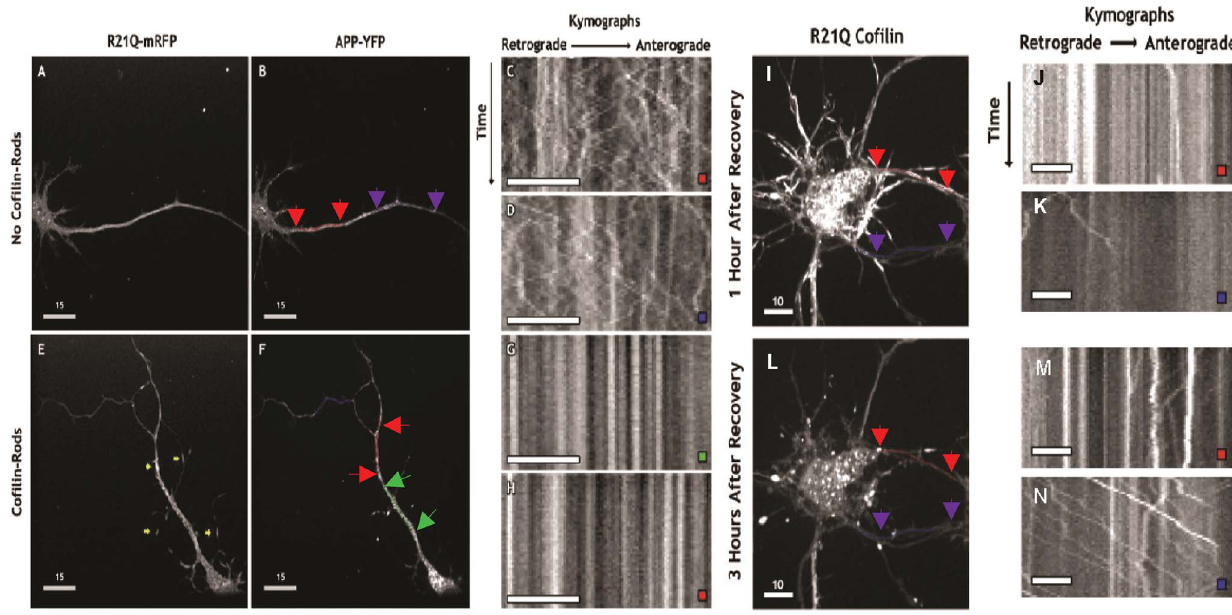
Figure 7. Live-imaging of AMPA-induced cofilinR21Q-mRFP labeled rods and their effect on vesicular transport before and after reversal. CofilinR21Q-mRFP and amyloid precursor protein (APP)-YFP dual infected neuronal cultures were treated with 25 m M AMPA for 45 min before imaging. Neurons expressing both fluorescent protein chimeras, which formed or did not form rods, were imaged once in the red channel to locate rods and then continuously for 12 sec (50 frames) in the YFP channel. In the AMPA-treated neuron that did not form rods (A), APP-YFP- containing vesicles (B) remain dynamic, as indicated by the retrograde (leftward) and anterograde (rightward) movements of the labeled vesicles in the kymographs (C, D) obtained from the regions of the neurite with red and purple line-scans (colored arrows demarcate the ends of the line scans) corresponding to the colored box on the kymographs. In the AMPA-treated neuron that formed rods (E, yellow arrows), APP-YFP-containing vesicles (F) stopped moving, as indicated by the lack of retrograde (leftward) and anterograde (rightward) movements of the labeled vesicles in the kymographs (G, H) obtained from the regions of the neurite with green and red line-scans (F) corresponding to the colored box on the kymographs. (Scale bars on images A, B, E, F are 15 m m and on kymographs C, D, G, H are 8 m m). In another set of experiments cofilinR21Q-mRFP and APP-YFP expressing neurons were treated 30 min with 25 m M AMPA to induce rods and then washed once with fresh medium and treated with 10 m M DNQX to prevent further AMPA-receptor activity. Neurons with rods were identified in the red channel. One hour after washout rods were still present in many processes (I) and APP-YFP containing vesicles were generally not dynamic, although a few exceptions were observed in kymographs taken along two different line scans (J, K). By three hours after washout (L), most rods have disappeared and APP-YFP vesicles are more dynamic (M, N). Line scans in I and L are not identical due to slight morphological changes that occur during recovery. (Scale bars on I, L=10 m m and on kymographs J, K, M, N=5 m